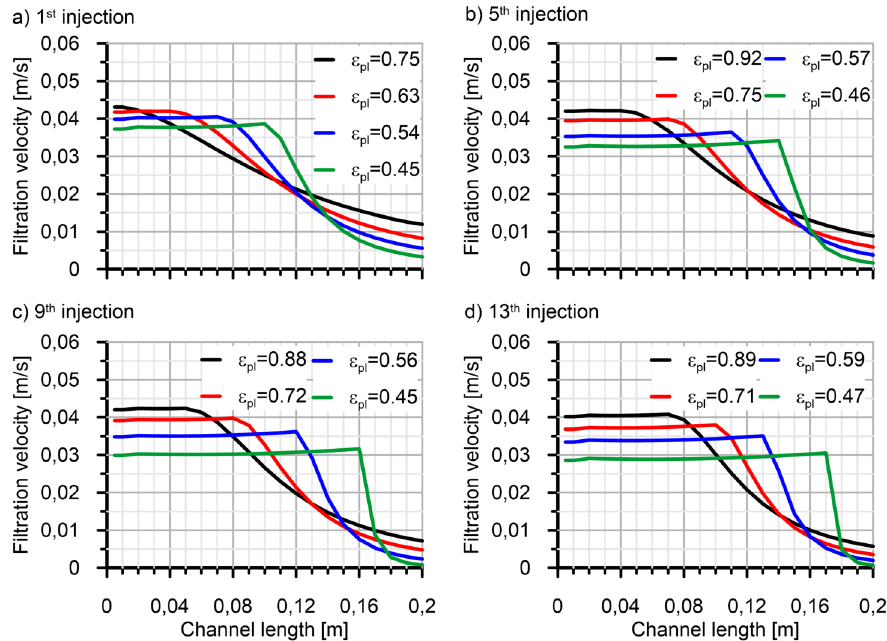
Figure 10. Filtration velocity profiles for different soot mass distribution onsets and particulate layer porosities providing the experimental pressure drop after every modeled injection event in DPF